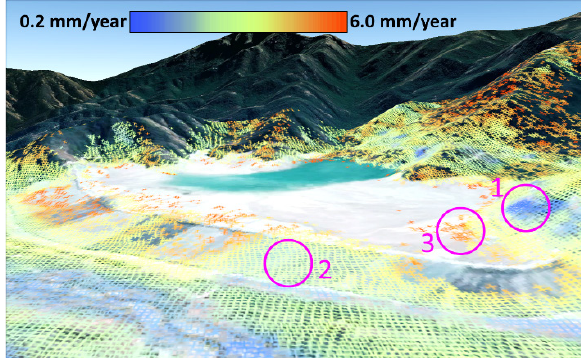
Figure 4. SBAS deformation precision map (mm/year). Areas 1, 2, 3: facility, dam, tailing. Background, Google Earth image.